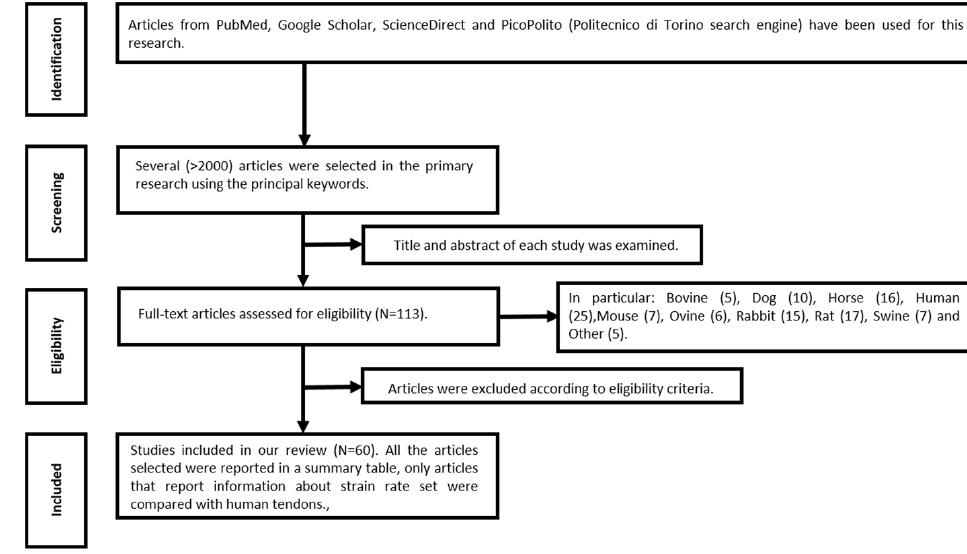
Figure 1. Flow chart of studies identified, reviewed, and excluded from the review.